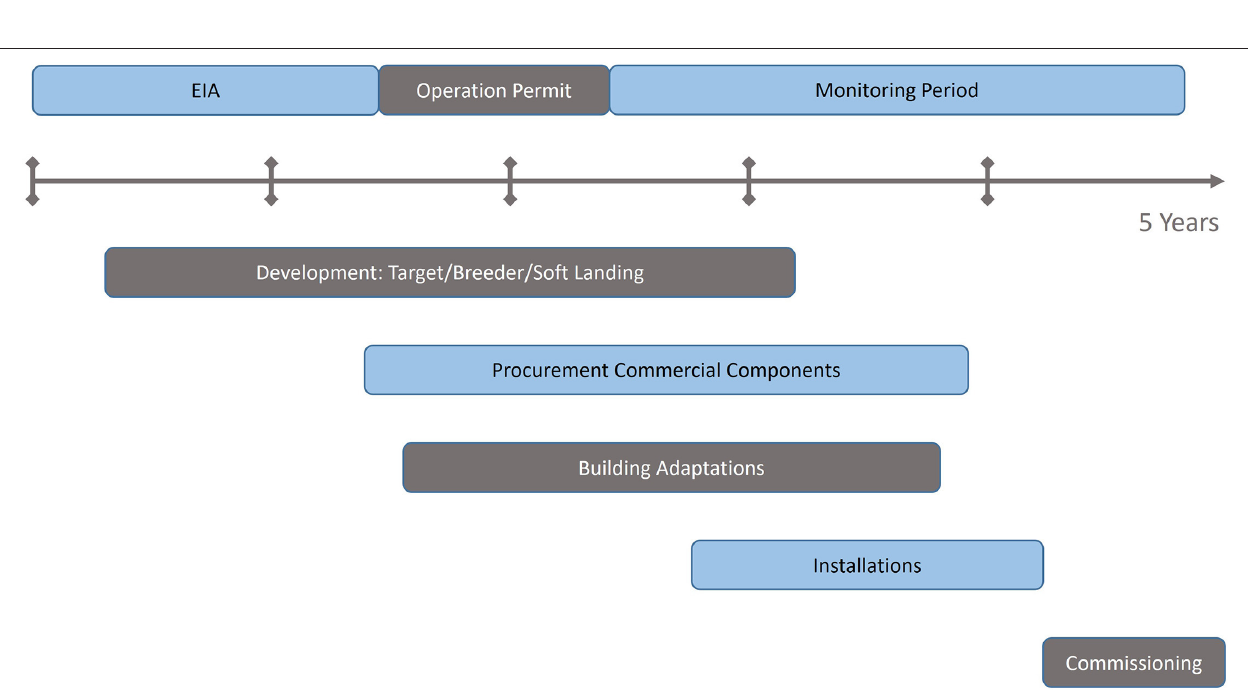
Frontiers in Medicine |